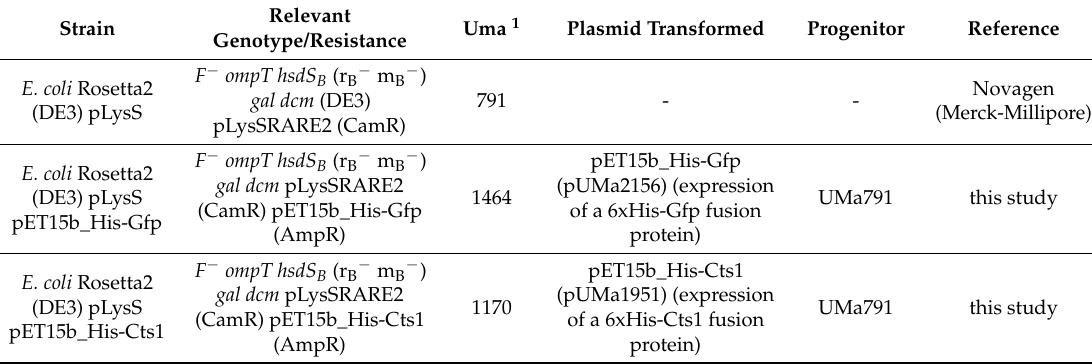
Table 1. E. coli strains used for protein